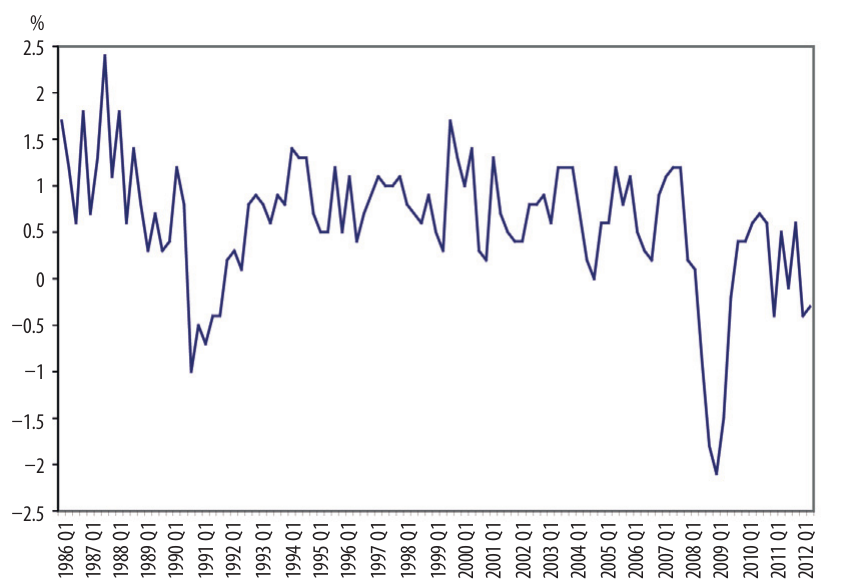
Fig. 1. UK GDP 1986 Q1 – 2012 Q1: Quarter on quarter growth (Office of National Statistics 2012)